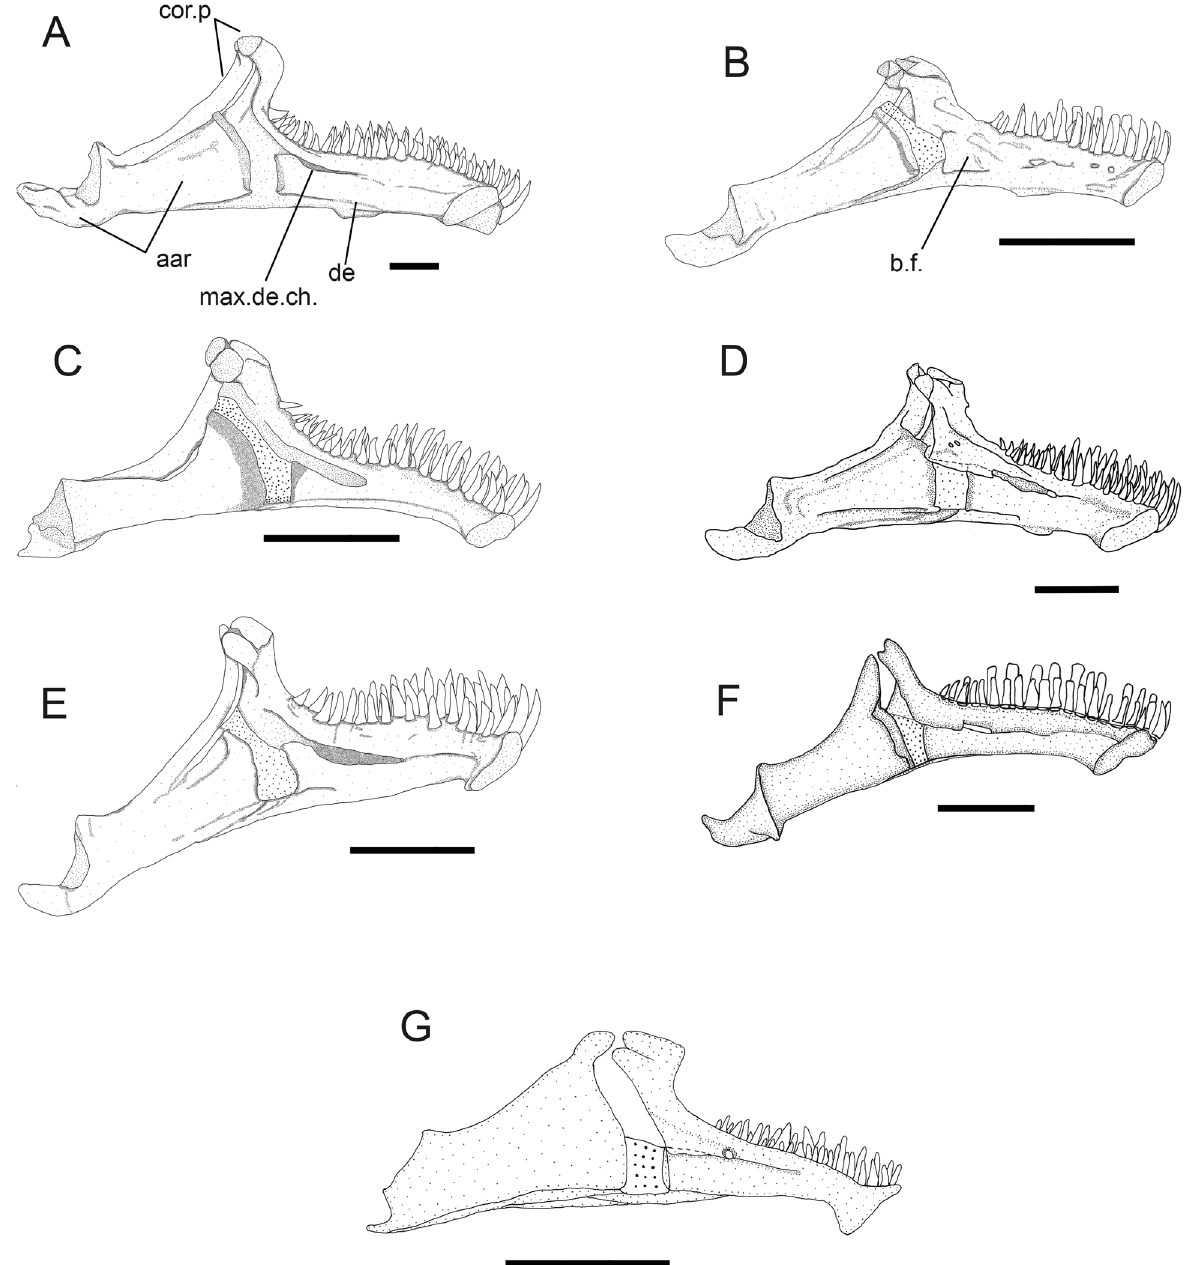
Figure 4. Left lower jaw in medial view. A Trichomycterus giganteus , UFRJ 5732, paratype. B Cambeva davisi , UFRJ 10713. C Trichomycterus alternatus , UFRJ 9900. D Cambeva zonata , UFRJ 11900. E Trichomycterus brasiliensis , UFRJ 4834. F Cambeva brachykechenos , UFRJ 10586. G Scleronema operculatum , UFRJ 11856. Scale bar: 1 mm aar, anguloarticuloretroarticular; corp.p, coronoid process; de, dentary; max.de.ch., maxillo-dentary channel; b.f. bone